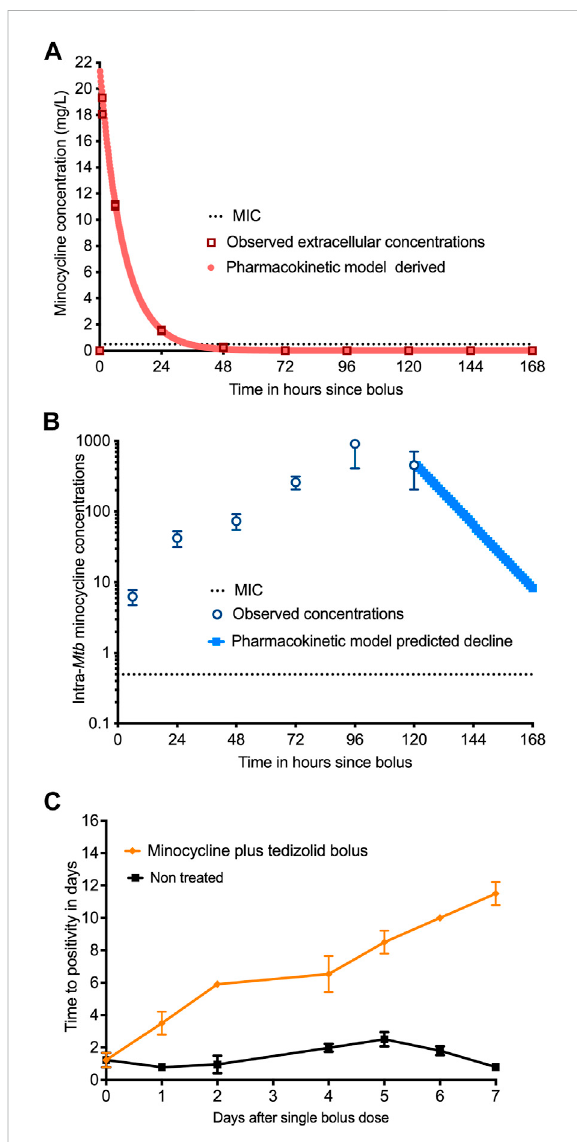
FIGURE 4 Measurement of intra-bacterial minocycline concentrations. (A) Extracellular minocycline concentrations following once-a- week dosing against Mtb fell below MIC after 48 h similar to the fi rst HFS-TB experiment. (B) Intra-bacterial (inside Mtb ) minocycline concentrations persisted above MIC well beyond 48 h, and the concentration-time curve lagged by 4 days behind extra-bacterial pharmacokinetics. (C) There were three replicate HFS-TB units treated with a single bolus dose of tedizolid and minocycline, at a half-life of 12 h. In parallel with measuring the intra-bacterial concentrations, we also quanti fi ed the bacterial burden using TTP in days. The fi gure shows continued microbial kill even after the minocycline extracellular concentrations dropped below the MIC in extracellular HFS-TB compartment by 48 h,whichwashowever,paralleltotheintra- Mtb